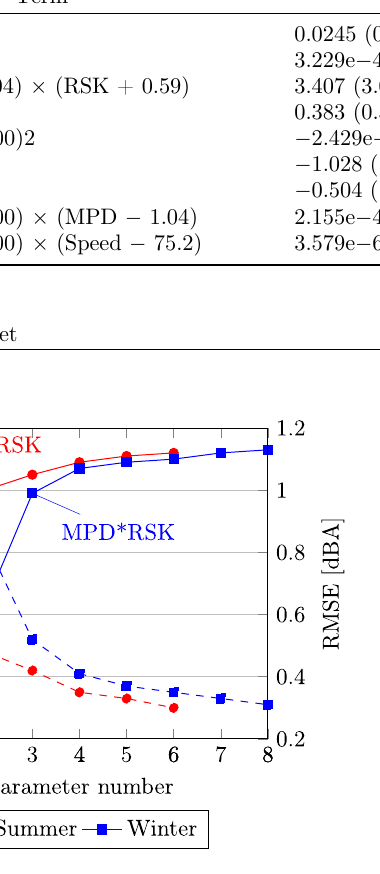
Figure 11. In fl uence of the number of parameters on the multiple linear regression ’ s quality of fi t. The plain lines correspond to the coef fi cient of determination R 2 . The dashed lines depict the RMSE. The parameter number corresponds to the fi rst column of Tables 3 and